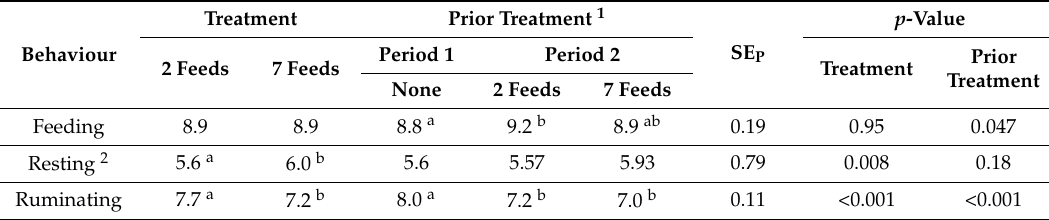
Table 3. Linear mixed models examining the effects of feeding frequency (2 allocations = 2 feeds per day; 7 allocations = 7 feeds per day) on the time (h per cow and day) cows spent feeding, resting, and ruminating. Least square means and pooled standard errors (SE P ) are presented.